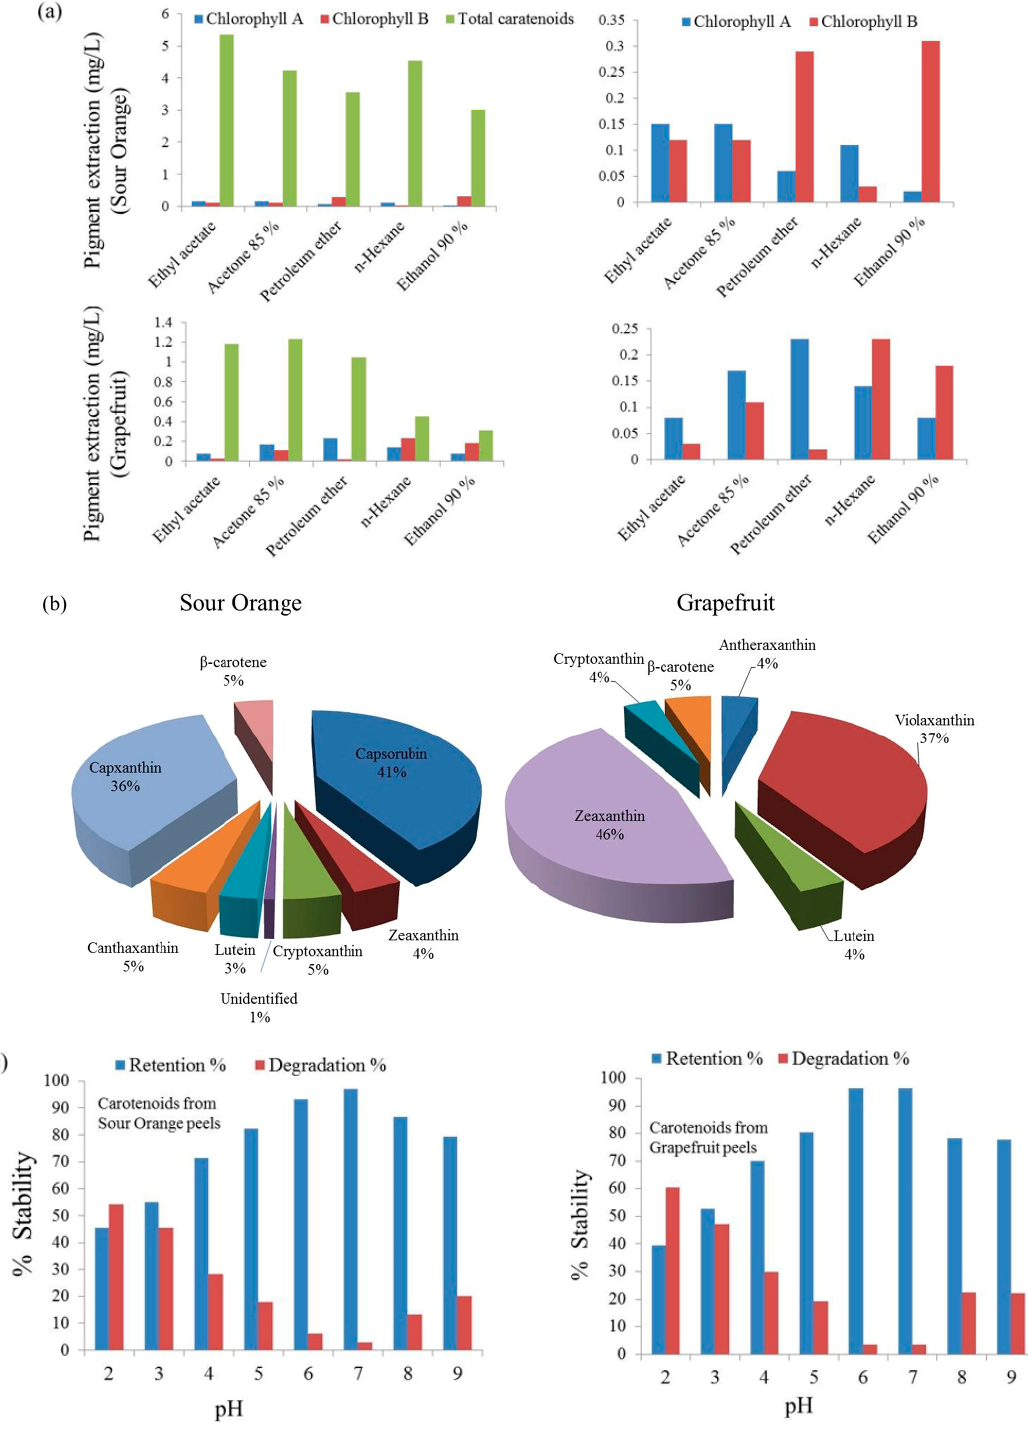
Figure 8. ( a ) Extraction of pigments in different solvents, ( b ) pigment composition, and ( c ) stability of the extracted pigments at different pH [122] .